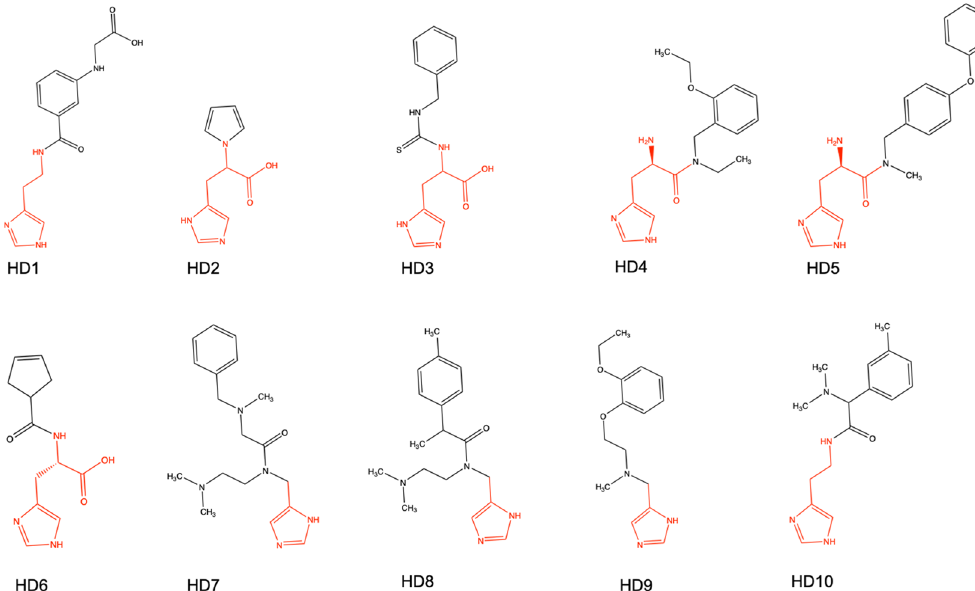
Figure 2. Histidine/Histamine derivatives library. Red color represents histidine/histamine mimicking moiety, and black represents the different functional groups tested. HD2 and HD3 are racemic mixtures.